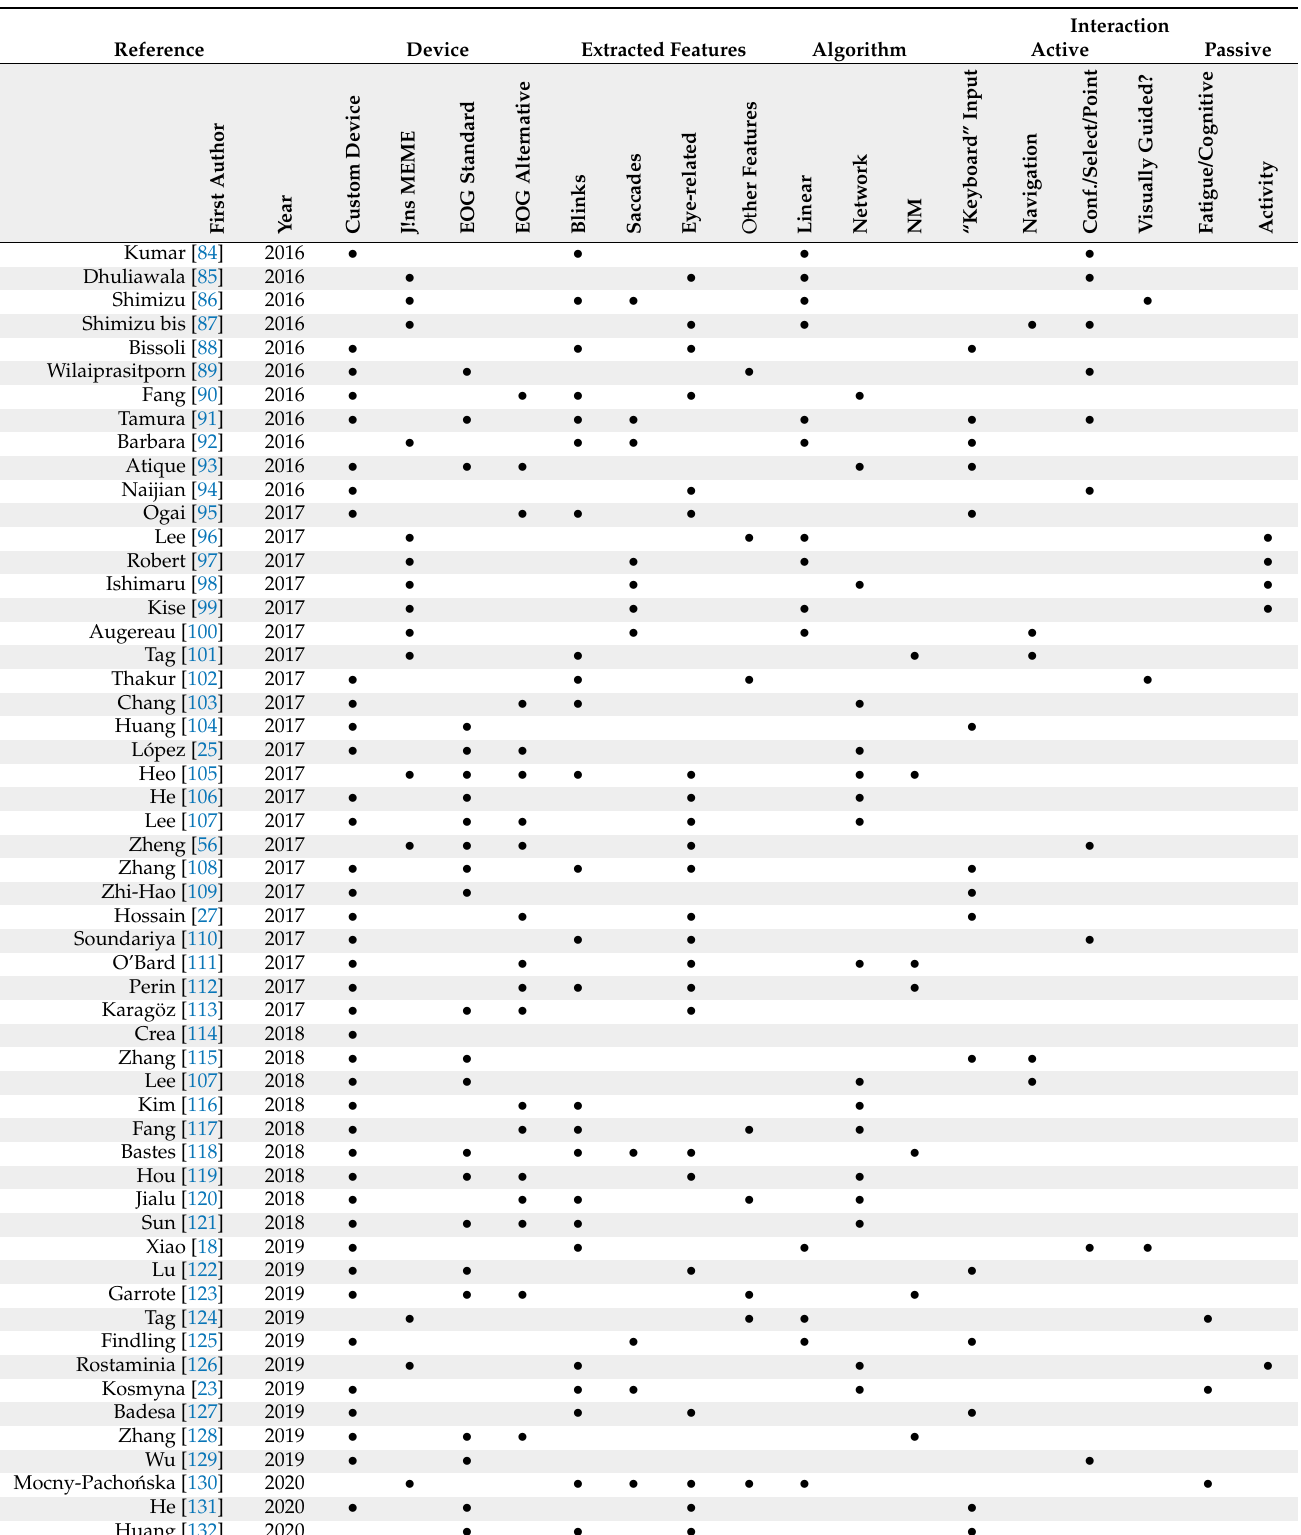
Table 2. Years 2016–2020. Pair rows are highlighted in gray for the ease of the